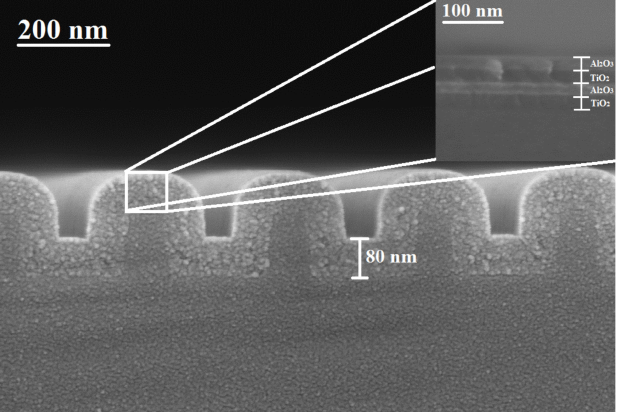
Figure 8. SEM image of a resonant waveguide grating structure with a TiO as the waveguide layer, on a fused silica